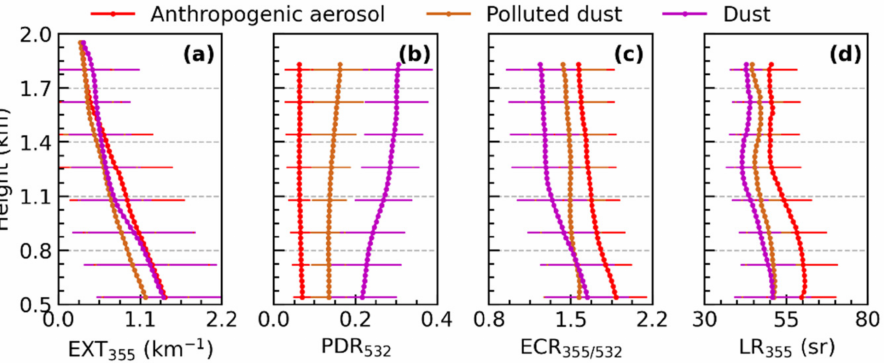
Figure 9. Average vertical profiles of aerosol optical parameters of key aerosol types in North China. Vertical structure of ( a ) EXT 355 , ( b ) PDR 532 , ( c ) ECR 355/532 , and ( d ) LR 355 . The envelope over the horizontal bars represent one standard deviation at each